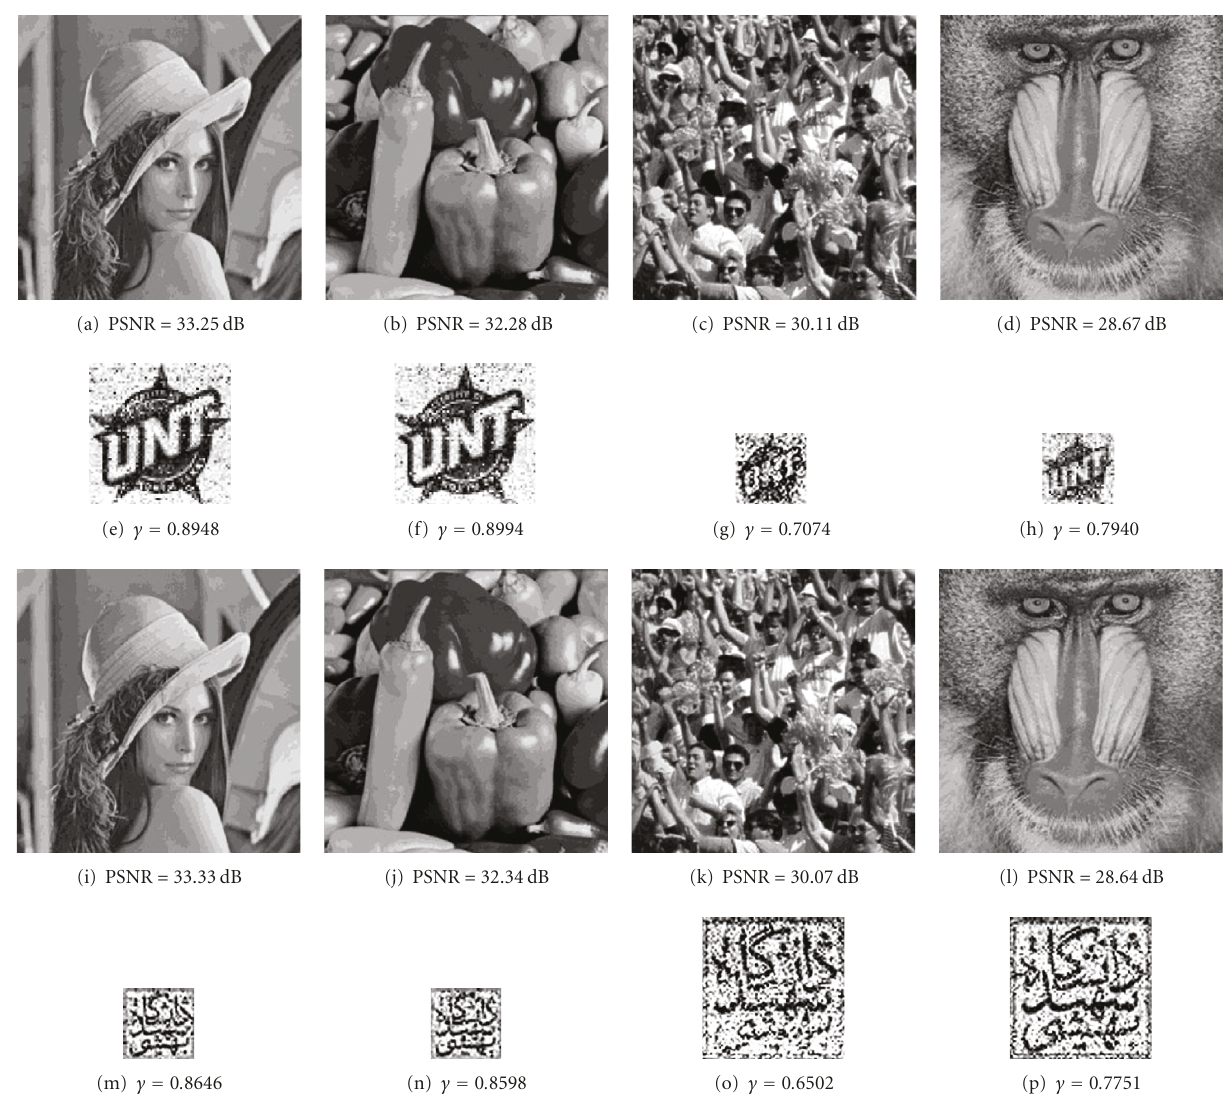
Figure 18: (a) and (b) The Lena and Peppers watermarked images with 256 × 256 watermark image as shown in Figure 11(b) after performing Gaussian lowpass filter with window size 5 × 5, (e) and (f) the extracted watermarks with size 256 × 256 from (a) and (b), respectively. (c) and (d) Crowd and Baboon watermarked images with 128 × 128 watermark image as shown in Figure 11(b) after performing Gaussian lowpass filter, (g) and (h) the extracted watermarks with size 128 × 128 from (c) and (d), respectively. (i) and (j) Lena and Peppers watermarked images with 128 × 128 watermark image as shown in Figure 11(d) after performing Gaussian lowpass filter, (m) and (n) the extracted watermarks with size 128 × 128 from (i) and (j), respectively. (k) and (l) Crowd and Baboon watermarked images with 256 × 256 watermark image as shown in Figure 11(d) after performing Gaussian lowpass filter, (o) and (p) the extracted watermarks with size 256 × 256 from (k) and (l),